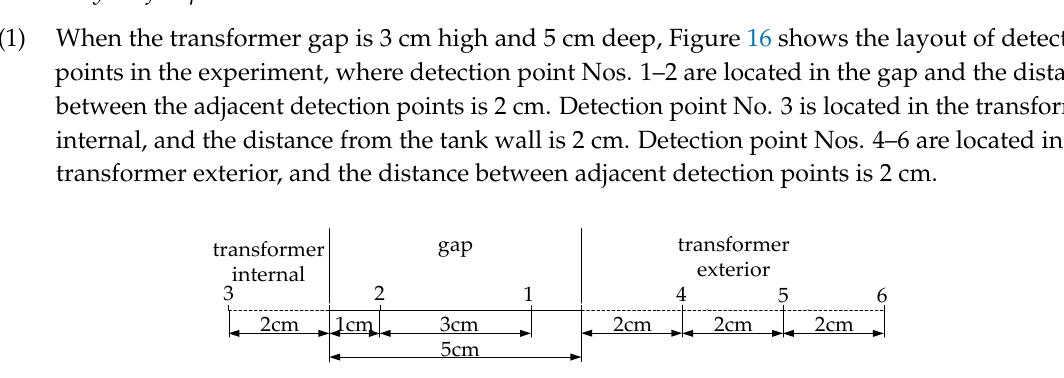
( b ) Figure 17. Distributions of electromagnetic signals radiated by PD source in different directions in experiment: ( a ) Amplitude distribution; ( b ) Cumulative energy distribution. Figure 17 illustrates that, inside the gap, the intensity of the electromagnetic wave radiated by PD source in different directions is significantly different. The intensity of the electromagnetic wave radiated by the PD source, which is in Y- and Z-axis positive directions, is considerably larger than that of X-axis positive direction. In the propagation process of electromagnetic wave from gap to transformer exterior, the intensity of electromagnetic wave radiated by PD source in Y- and Z-axis positive directions, suddenly decreased. And the intensity change of the electromagnetic wave radiated by the PD source in X-axis positive direction is not evident. Therefore, in the gap detection of transformer PD electromagnetic wave signal, inserting the antenna sensor into the transformer gap will considerably improve the detection sensitivity. Each of the four gaps of transformer is required to be set with an antenna sensor to achieve full range and a high-sensitivity detection of the electromagnetic wave. This conclusion is consistent with that of the simulation results shown in Figure 10. (2) When the transformer gap is 5 cm deep and the PD source is oriented in Z-axis positive direction, the gap heights are 4, 3, and 2 cm separately. In addition, the electromagnetic wave signal is obtained according to the detection point layout in Figure 16. Figure 18 shows the experimental results.